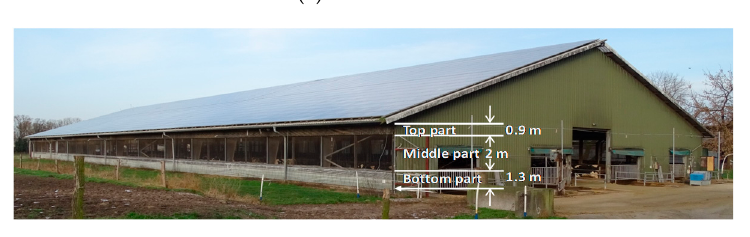
Figure 1. Sidewall opening practices of the naturally ventilated dairy (NVD) barn in Dummerstorf, Germany in different seasons, ( a ) in summer, ( b ) in early spring and autumn, and ( c ) in winter. 2.2. Wind Tunnel Experiments for CFD Model Validation Before analyzing the airflow pattern, the CFD model validation is necessary to ensure adequate results [23]. This can be done best under constant boundary conditions; hence wind tunnel experiments are ideal for that purpose. In this study, boundary layer wind tunnel (BLWT) (ATB, Potsdam, Germany) at the Leibniz Institute for Agricultural Engineering and Bioeconomy (ATB) was used for data generation in constant environmental condition and model validation. 2.2.1. Description of the Wind Tunnel and a Scale Model of NVD Building The experiments were carried out in a large BLWT at the ATB. The BLWT is 20 m long, 3 m wide and 2 m high with adjustable ceiling up to 0.25 m (Figure 2). The inlet of the BLWT is fitted with honeycombs (Sennur Camur, Bad Saeckingen, Germany) at the inlet nozzle and has a Prandtl tube sensor connected to a pressure transducer (MKS Baratron R Type 120A, MKS Instruments, USA) near the inlet to measure the inlet velocity. The inflow section between inlet and test section had a length of approximately 10 m and was equipped with roughness elements of different heights to generate a turbulent boundary layer. The outlet of BLWT is fitted with an axial fan of (diameter 2.8 m), which can provide a maximum wind speed of 20 m ∙ s − 1 . A 1:100 scale model of the NVD building located in north-east Germany was built for the BLWT experiment as described in Figure 1. The dimensions of the scale model are 0.962 m (length) × 0.342 m (width). The eave height and the ridge height are 0.042 m and 0.107 m, respectively (Figure 3a). This resulted in a wind tunnel blockage ratio of 1.72%, which is lower than the recommended maximum value of 5% for scaled model and wind tunnel experiments [24]. The inflow profile was fulfilled the criteria for a boundary layer over a moderately rough terrain according to the VDI guideline for Physical Modelling of Flow and Dispersion Processes in the Atmospheric Boundary Layer [25]. With the barn model height as characteristic length and the local velocities at the barn, a